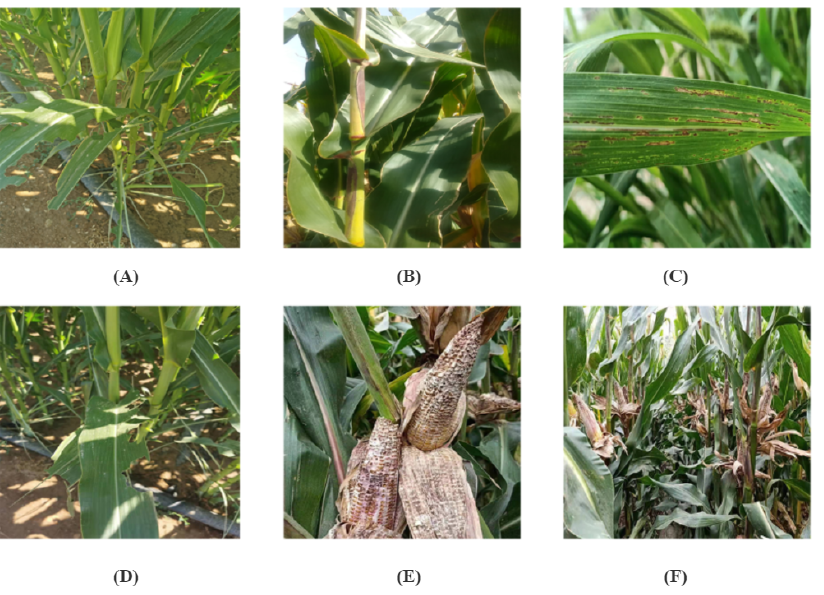
Figure 2. Different maize organs and plants block each other in the complex field environment, and the natural light is nonuniform and constantly changing, which may increase difficulties in recognition. ( A ) Shows the mutual shielding of leaves; ( B ) Displays the shielding of leaves and interferential shadows when photographing at a close distance; ( C ) Shows the situation that the blade occupies the whole view when taking a close shot; ( D ) Shows the influence of shadow and leaf deformity on recognition; ( E ) Shows the condition that the main body of the image is not the leaf; ( F ) Shows the image containing multiple